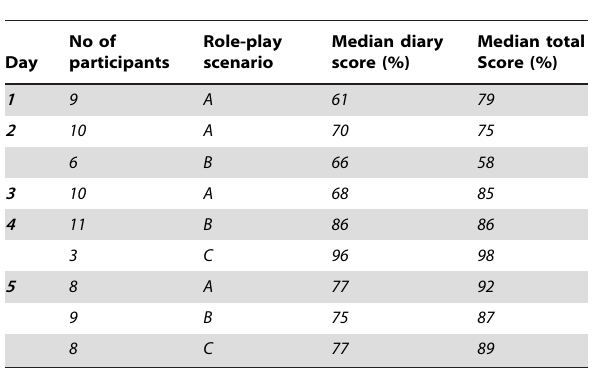
Table 1. Use of active reporting form over five pretesting and revision sessions.